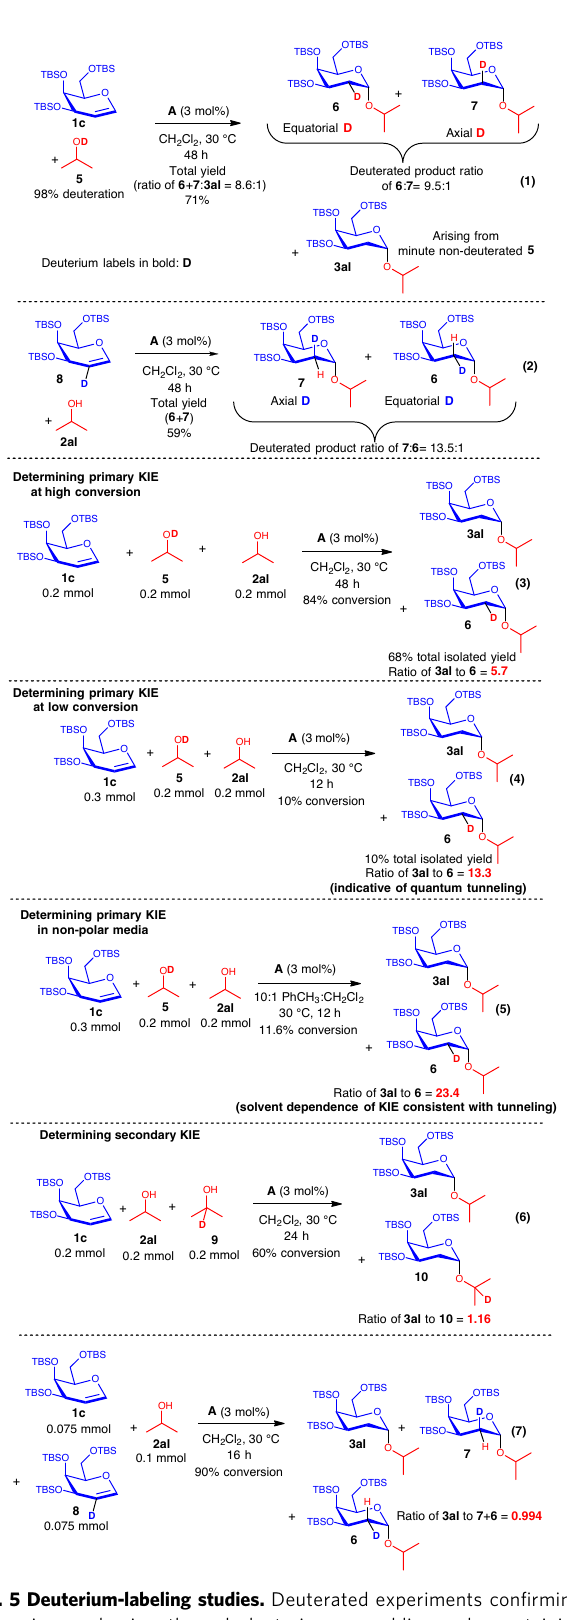
Fig. 5 Deuterium-labeling studies. Deuterated experiments con fi rming step-wise mechanism through deuterium scrambling and ascertaining source of C2 proton originates from the glycosyl acceptor. Intermolecular competition experiments to understand primary and secondary kinetic isotopic effects (KIEs), and KIE elevation to support quantum tunneling.